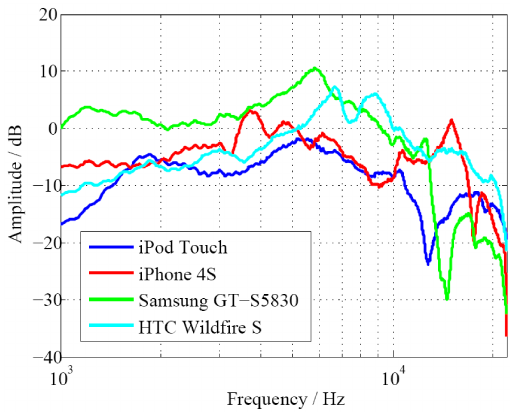
Figure 4. Normalized amplitude in dB vs. frequency for a sinus tone with different speakers of smartphones(adapted from Hoppe [19], with permission from c (cid:13) 2012 University of Freiburg).